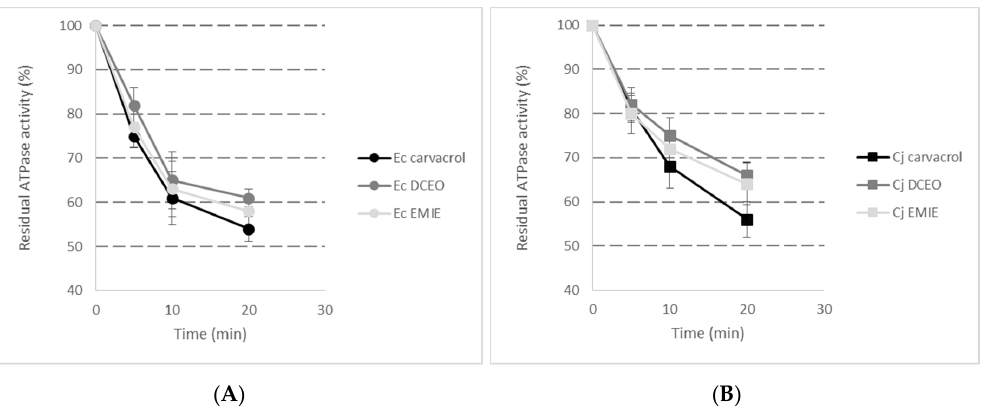
Figure 5. Residual ATPase activity after incubation with DCEO, EMIE, and carvacrol. ( A ) Measured on E. coli membrane fractions. ( B ) Measured on Campylobacter membrane fractions. Data are the means ± SEM from three independent experiments.